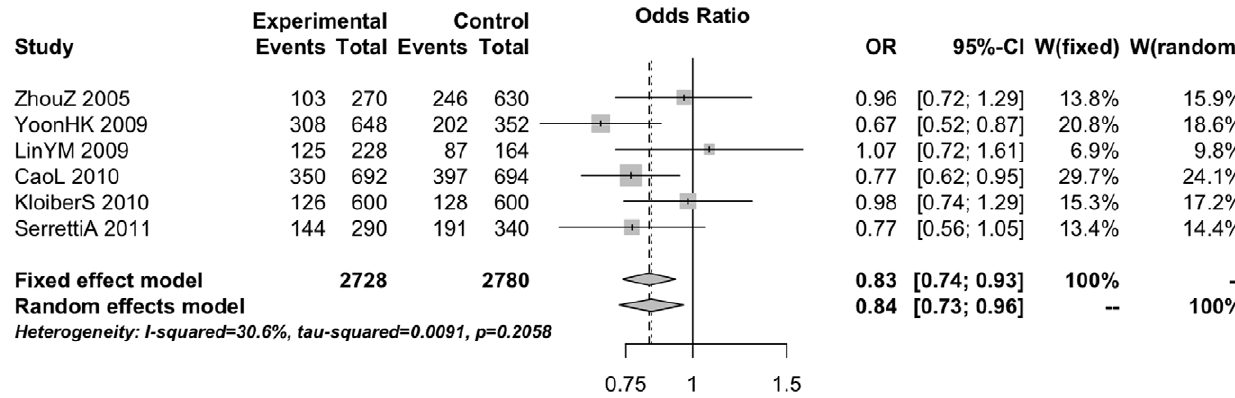
Figure 1. Forest plot of genetic association studies of rs4570625-T and major depression.